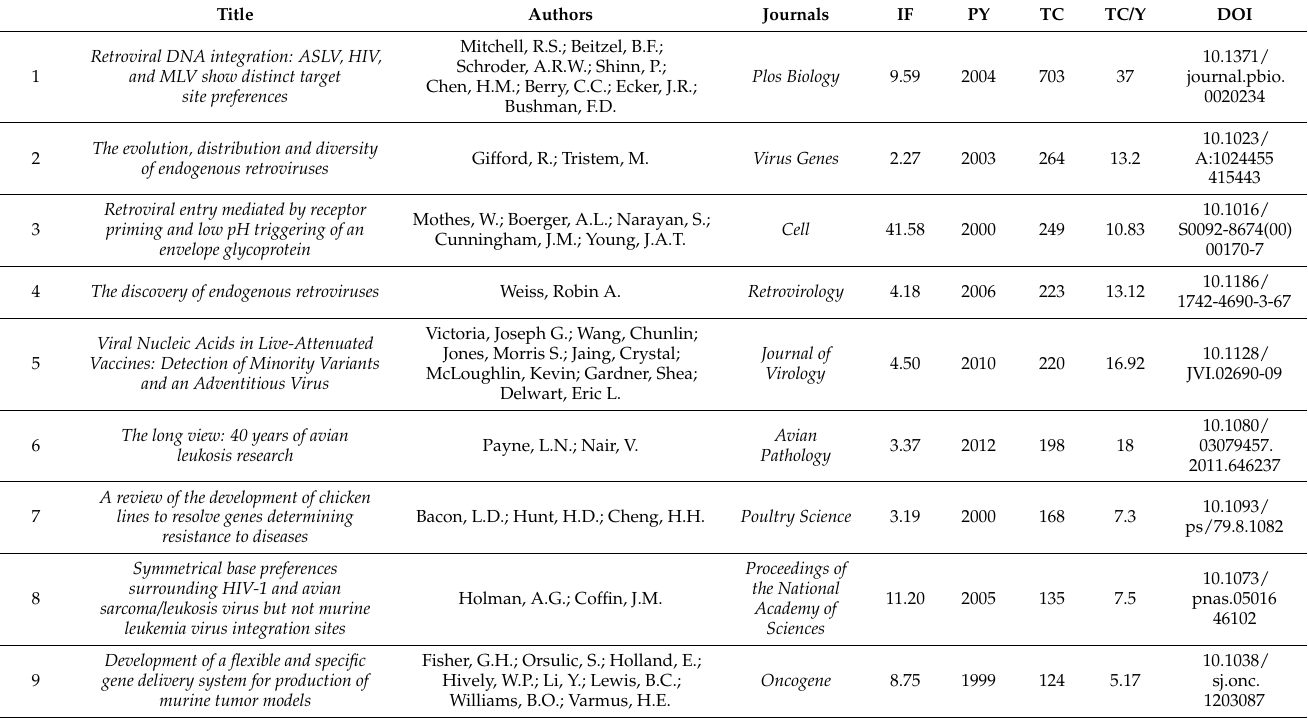
Table 4. Globally ten leading and highly cited articles in the field of avian leukosis virus.